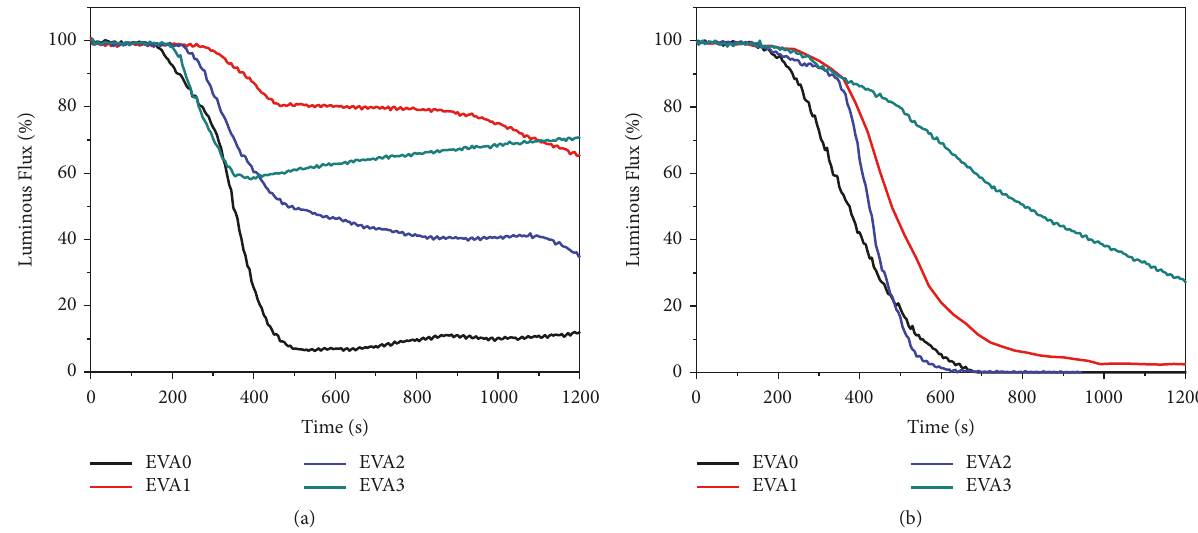
Figure 8: Luminous flux curves of EVA/LDHs composites: (a) with the application of a pilot flame and (b) without the application of a pilot flame.